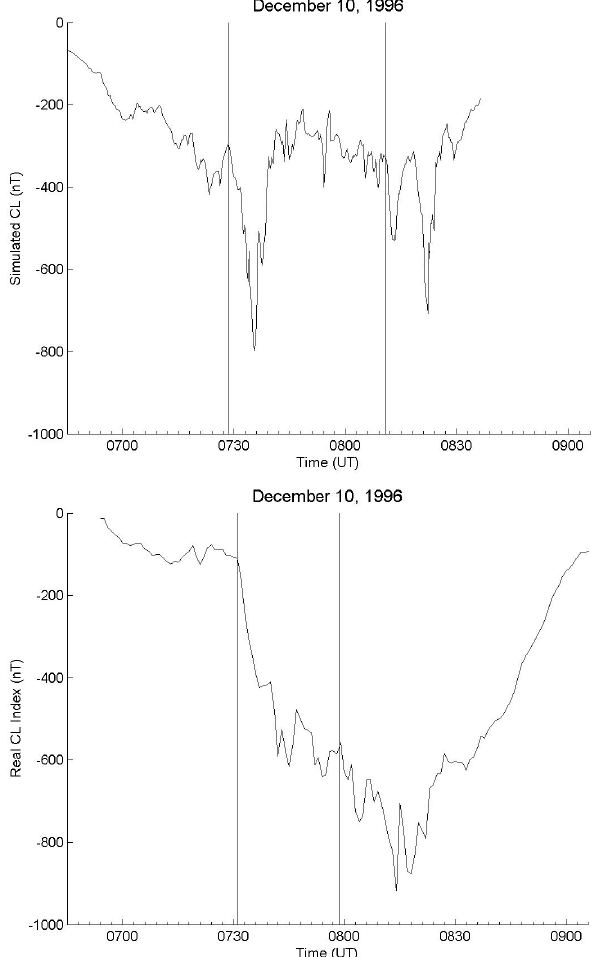
Fig. 5. A substorm pseudobreakup (first vertical line) followed by a true substorm expansion phase onset (second vertical line) on 10 December 1995. The real CL index is in the bottom panel and the simulation index is in the top